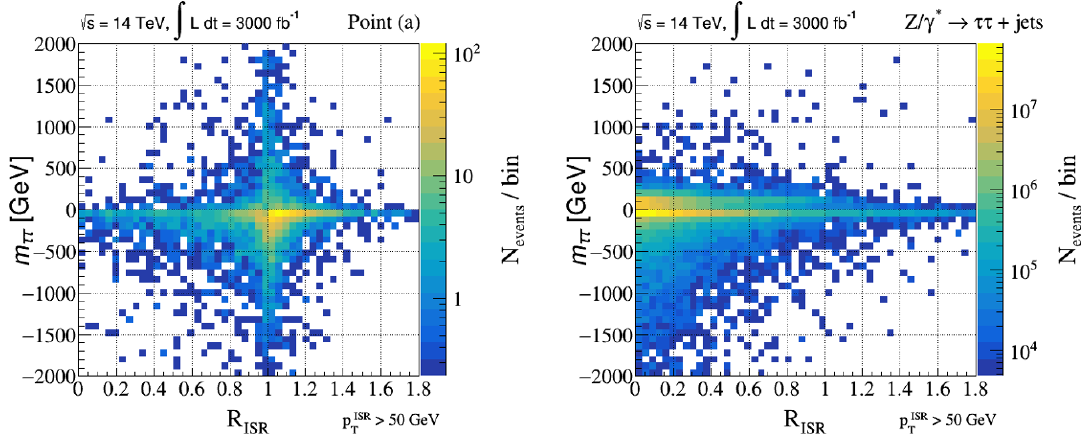
Figure 6. Two-dimensional distributions in R ISR and m (cid:28)(cid:28) for point (a) [left panel] and the dominant Z=(cid:13) (cid:3) + jets background [right panel]. Note that for the signal corresponding to model point (a) clustering of events occurs at R ISR = 1 (left panel) while for the background the clustering occurs far away from R ISR = 1. The simulation is at 14 TeV and for 3000 fb (cid:0) 1 of integrated luminosity with a 50 GeV cut on the transverse momentum of the leading